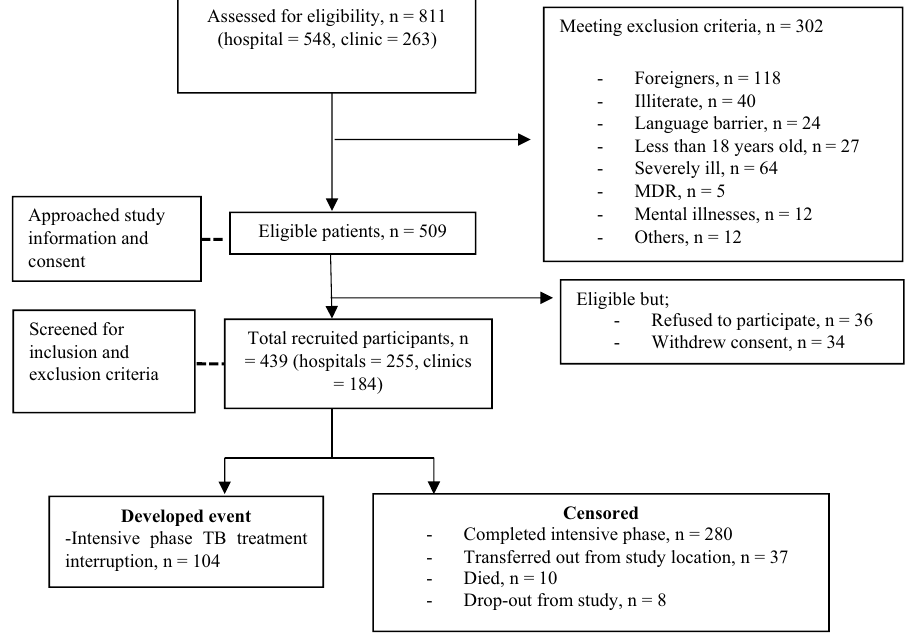
Figure 1. Study profile for the assessment of early treatment interruption among pulmonary TB smear-positive patients in urban districts, Selangor.